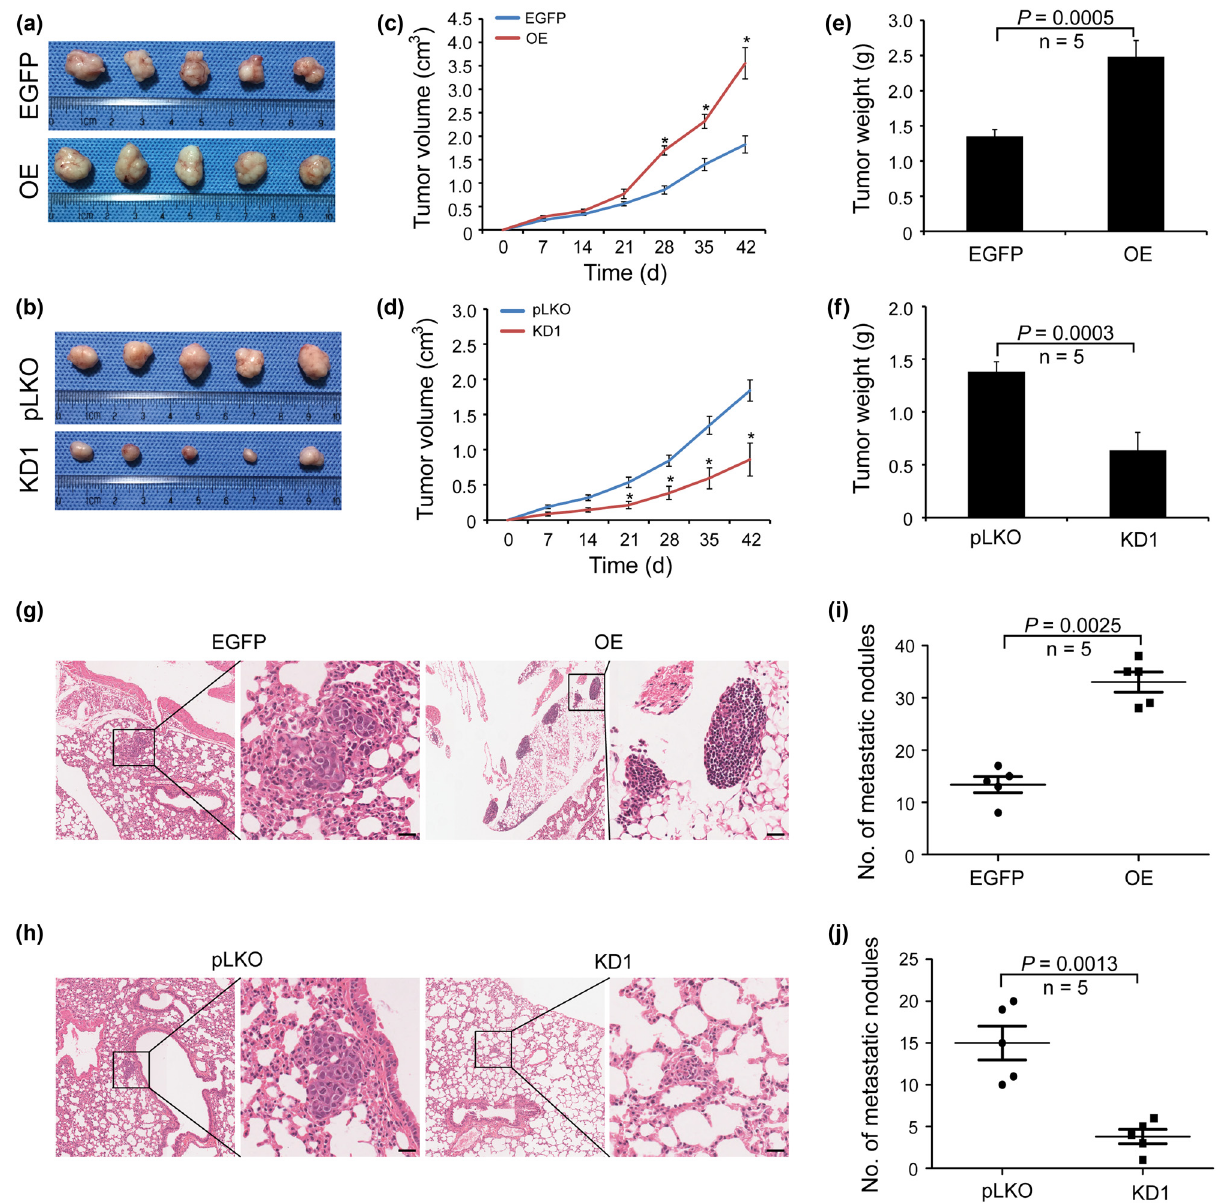
Figure 3: TET3 promotes proliferation and metastasis of ESCC cells in vivo . ( a – f ) Eca109 treated with OE and knockdown of TET3 sub - cutaneously injected in nude mice to construct animal model. Tumor volumes and weights were measured. n = 5 mice per each group. ( g – j ) Representative fi elds of metastatic tumor nodules in lung of each group of nude mice ( scale bar = 50 μ m ) . The numbers of metastatic tumor nodules in lung were statistically analyzed. Five mice per each group. * P <